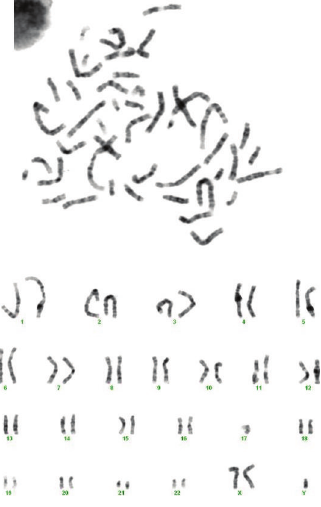
Figure 2: Karyotype showing the presence of an extra X chromo-